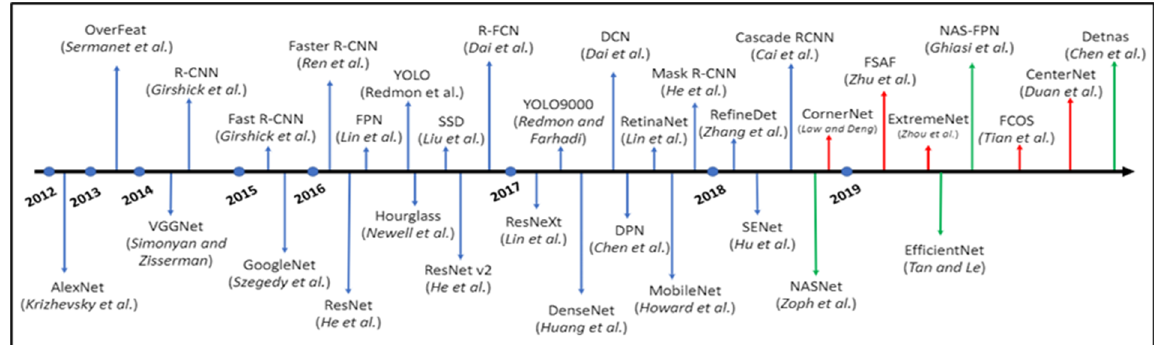
Figure 2. State-of-the-art AI-based object detection techniques.